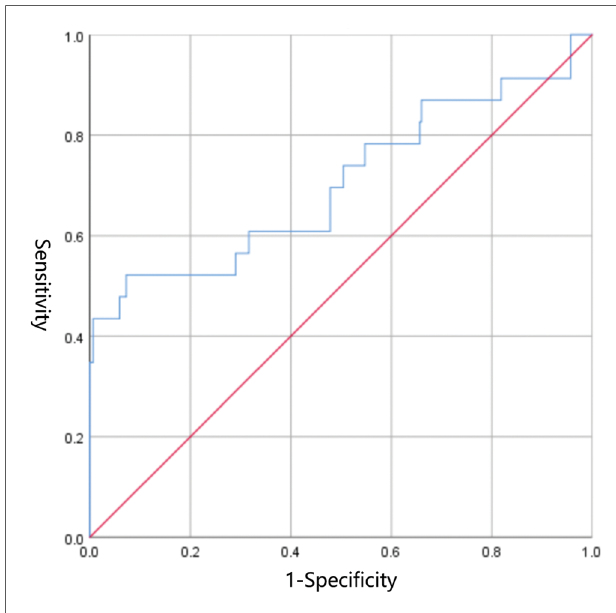
FIGURE 2 Receiver operating curve of S/D.